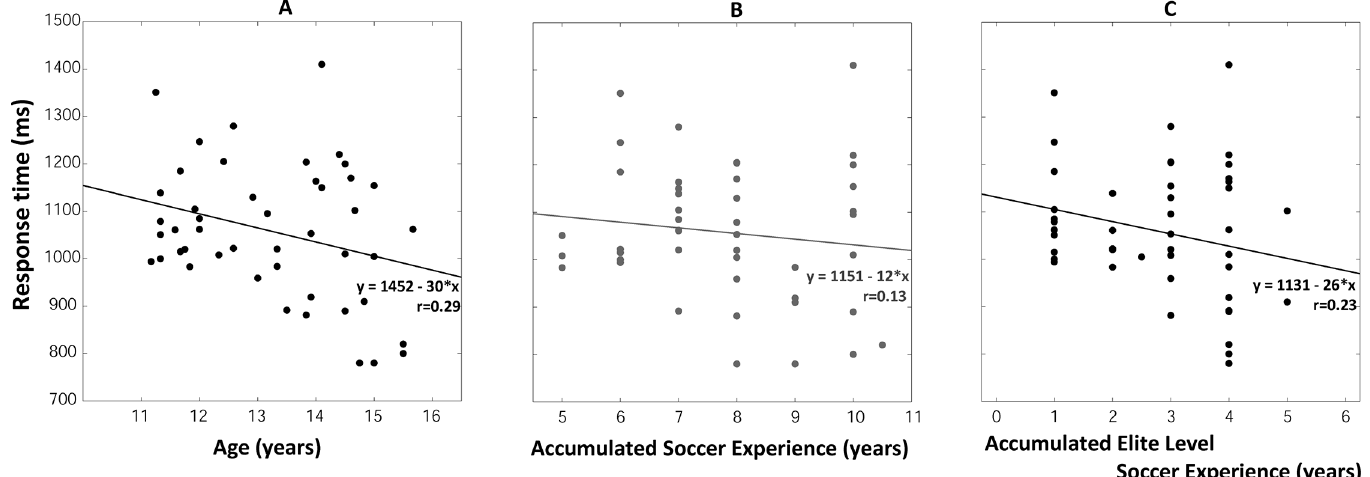
Fig 4. Response times of elite young soccer players as a function of age (A), accumulatedsoccer experience (B) and elite level-soccerexperience(C). https://doi.org/10.1371/journal.pone.0185460.g004 PLOS ONE | https://doi.org/10.1371/journal.pone.0185460 September 27,